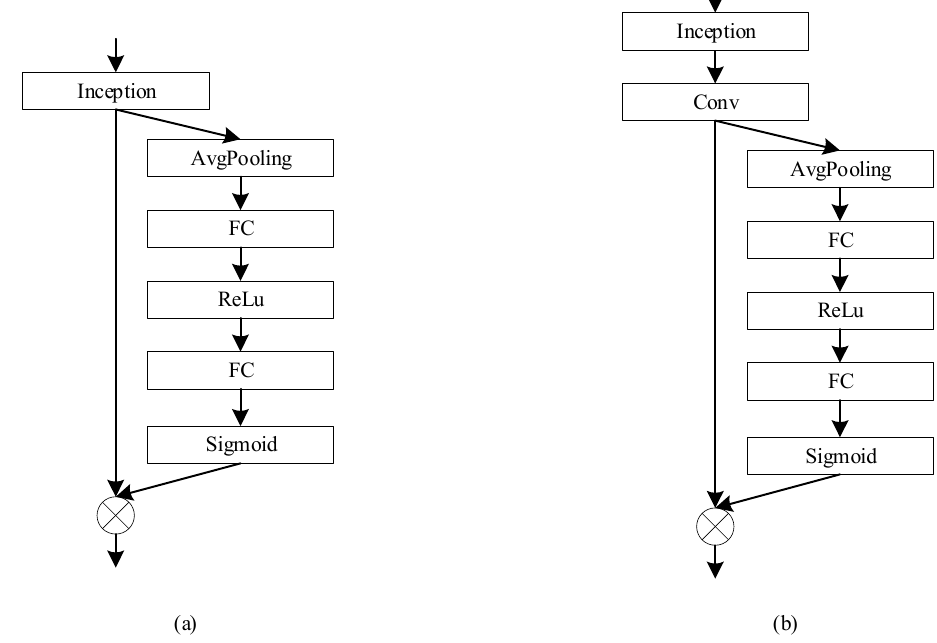
Figure 3. Comparison before and after SEB module improvement: ( a ) the original channel attention module SEB; ( b ) the improved channel attention module SEB.